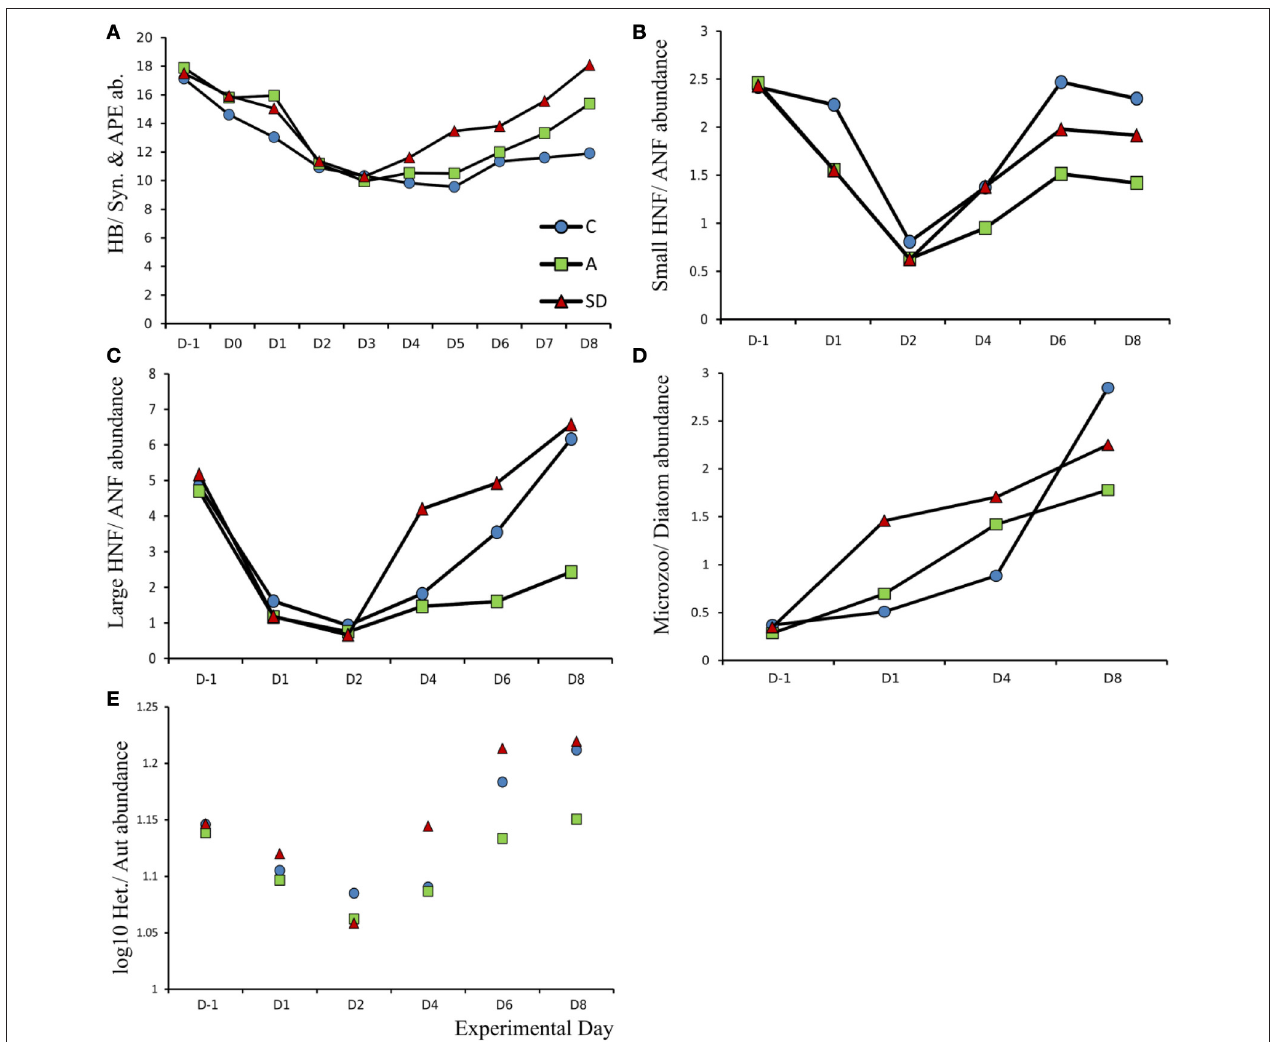
FIGURE 13 | Ratio of heterotrophic to autotrophic abundance for (A) Heterotrophic bacteria (HB) vs. Synechococcus (Syn) and autotrophic pikoeukaryotes (APE), (B) Small (ESD < 5 µ m) heterotrophic nanoflagellates (HNF) vs. small autotrophic nanoflagellates (ANF). (C) Large (ESD > 5 µ m) heterotrophic nanoflagellates (HNF) vs. small autotrophic nanoflagellates (ANF) (D) Microzooplankton (Microzoo) vs. Diatoms and (E) Pooled total abundance (Log10) of heterotrophs vs.